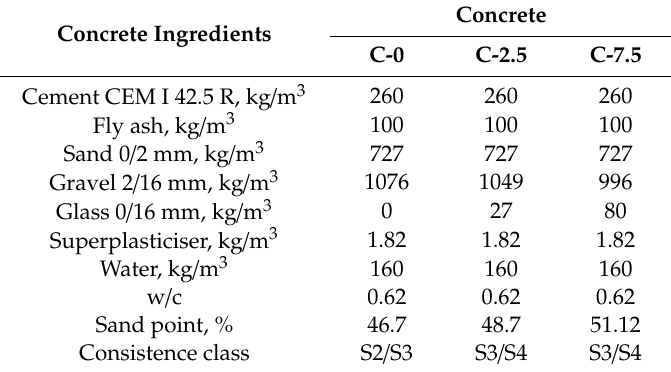
Table 7. Weight and volume composition of source